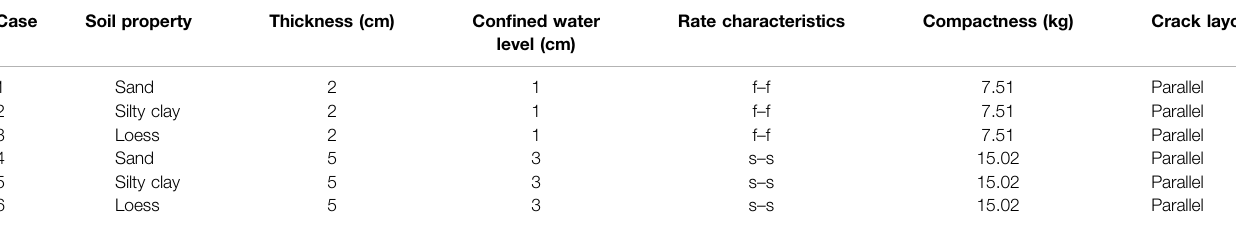
TABLE 2 | Test design of soil property